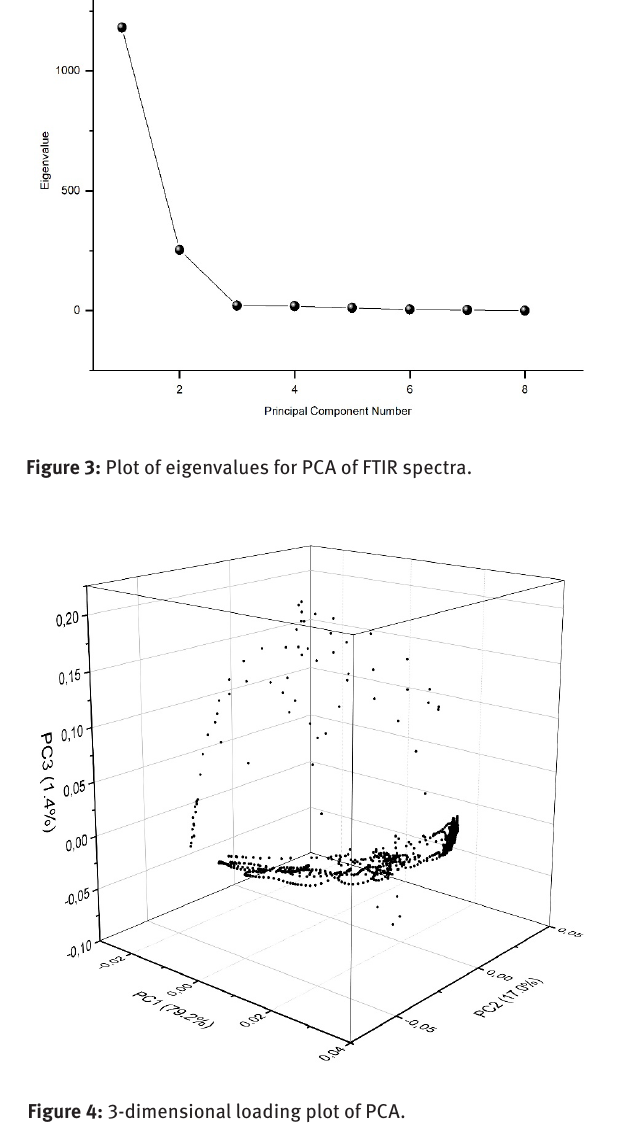
Figure 4: 3-dimensional loading plot of PCA.